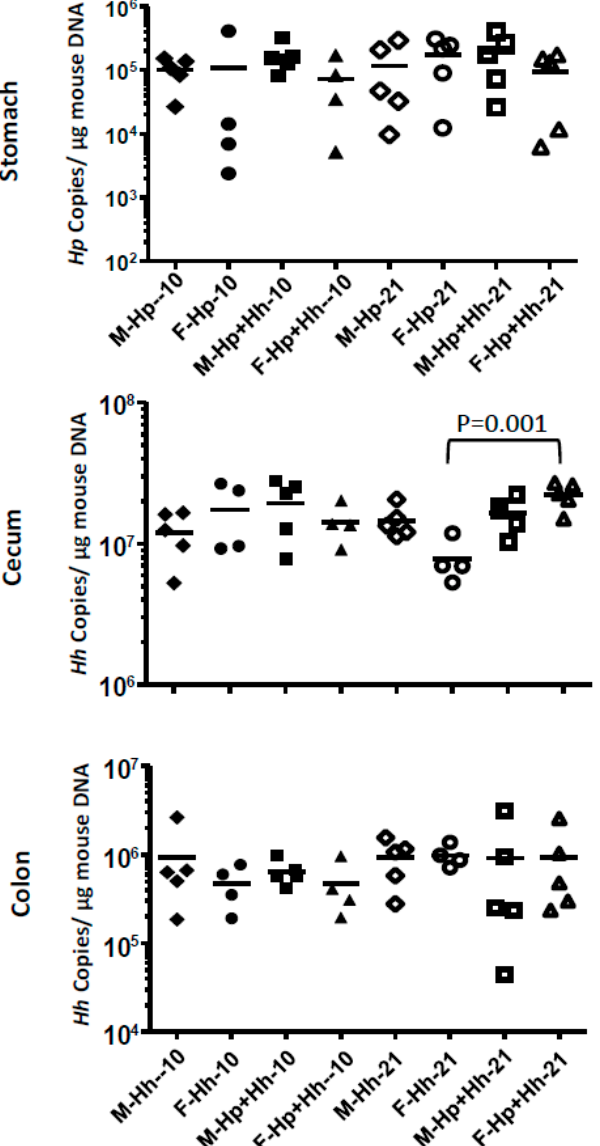
Figure 5. qPCR quantitation of gastric Hp and intestinal Hh. Copy numbers of gastric Hp PMSS1 or intestinal Hh genome are expressed per µg mouse DNA in the respective samples, determined using the 18S rRNA gene-based probe.